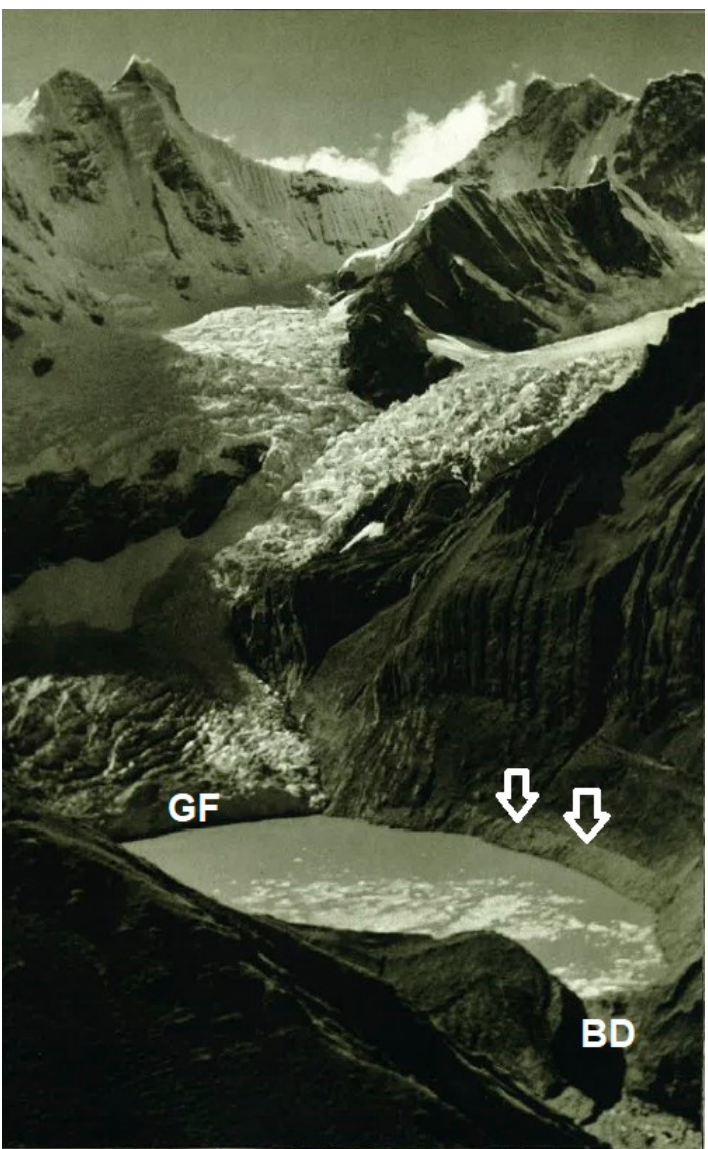
Figure 5. Lake Solteracocha in the 1930s (most likely in 1936), shortly after dam failure in 1932. Breached moraine dam (BD) is visible in lower right corner; arrows indicate pre-GLOF lake water level (also visible on Figure 3C). Note that the lake was still proglacial at the time (GF–glacier front). Image modified from [9].